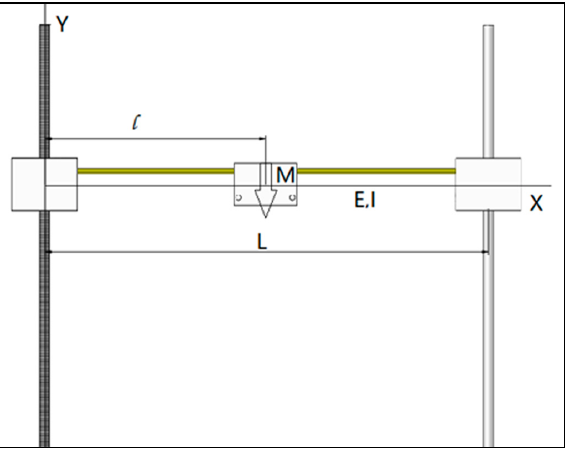
Figure 6. Schematic diagram of the simplified